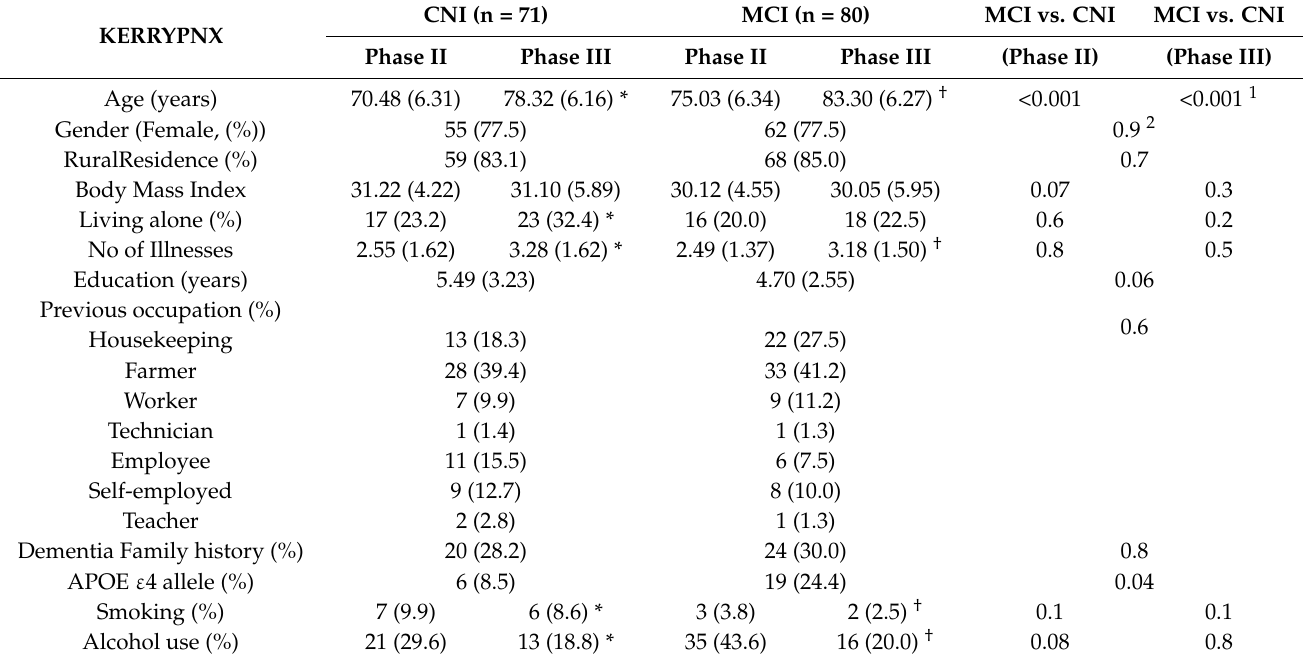
Table 1. Sociodemographic and medical characteristics assessed in Phase II and III for the cognitively non-impaired (CNI) and MCI participants (according to Phase II